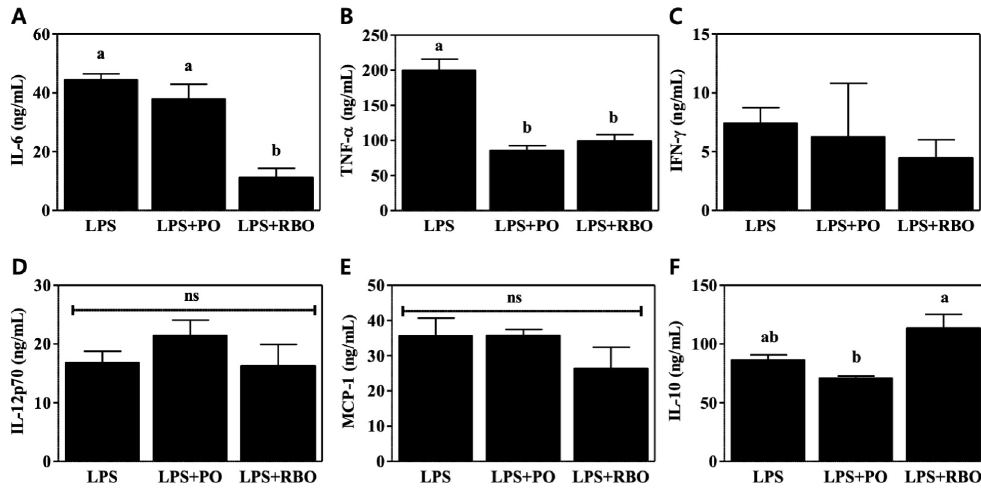
Fig 1. Cytokine production by LPS-stimulated RAW 264.7 macrophages, as assessed with a multiple-cytokine bead array. Data are presented as mean ± SEM (n = 5). Values with different letters are statistically significant at p < 0.05 within the panel. (PO, palm oil; RBO, rice bran oil).